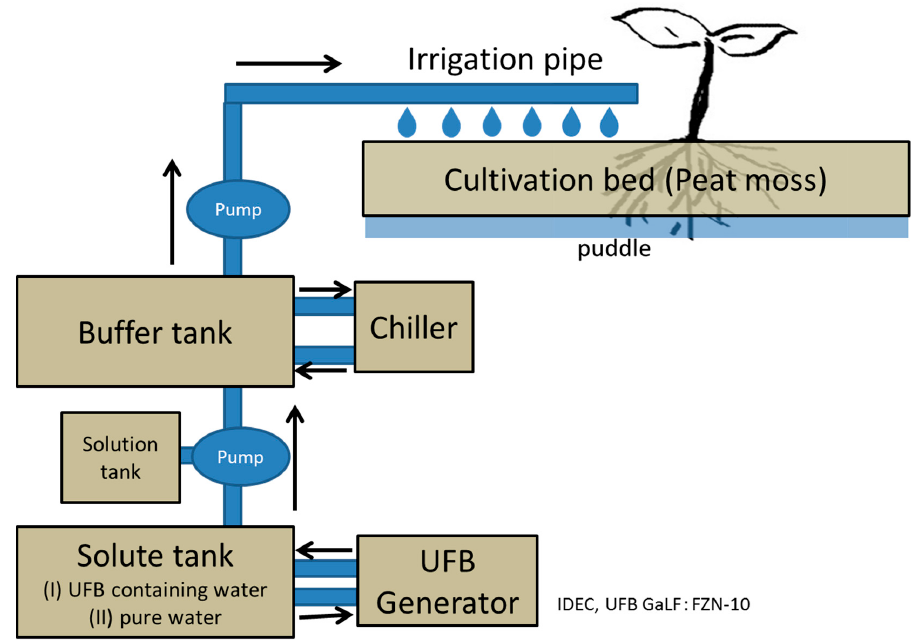
Figure 8. T he plant factory with ultra-fine bubbles (UFB)-added medium supply system. A second line system, identical except with pure water as a solute without UFB generator, is used for the control